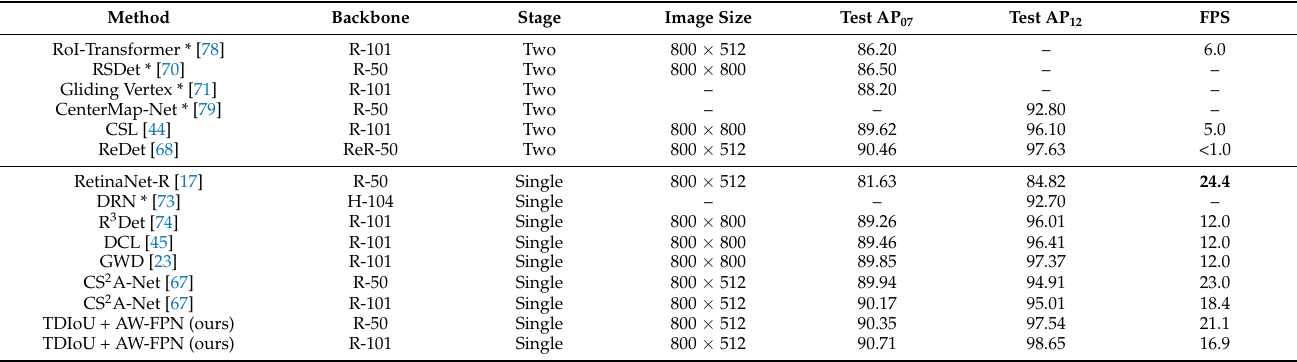
Table 12. Comparison with state-of-the-art methods on HRSC2016. The method with * indicates that its results are from the corresponding